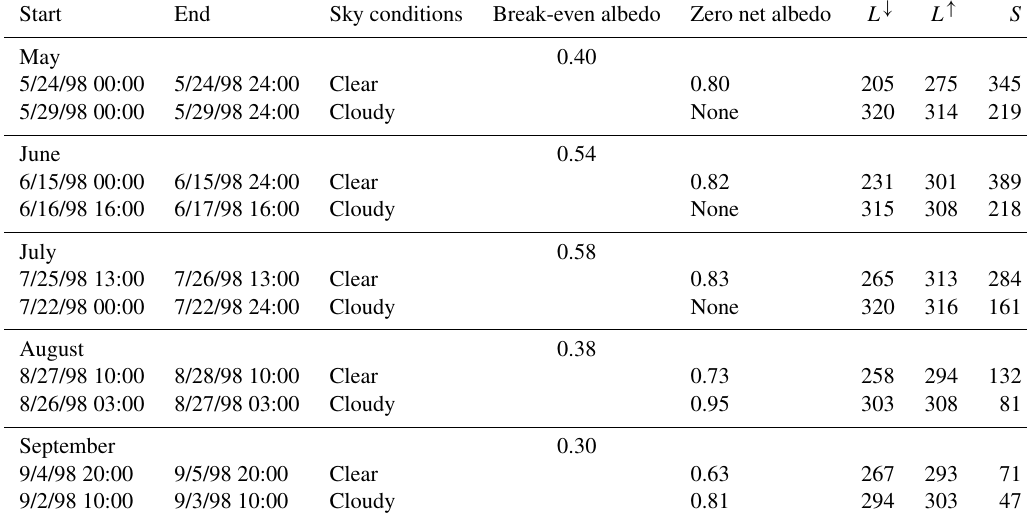
Table 1. Summary of monthly sunny–cloudy pairs including longwave and shortwave fluxes (Wm − 2 ), break-even albedos, and zero net albedos. L ↓ and L ↑ are the incoming and outgoing longwave radiation, and S is the incoming shortwave. A value of none for zero net albedo means that there is no physically realistic albedo (between 0 and 1) that gives a radiative balance of